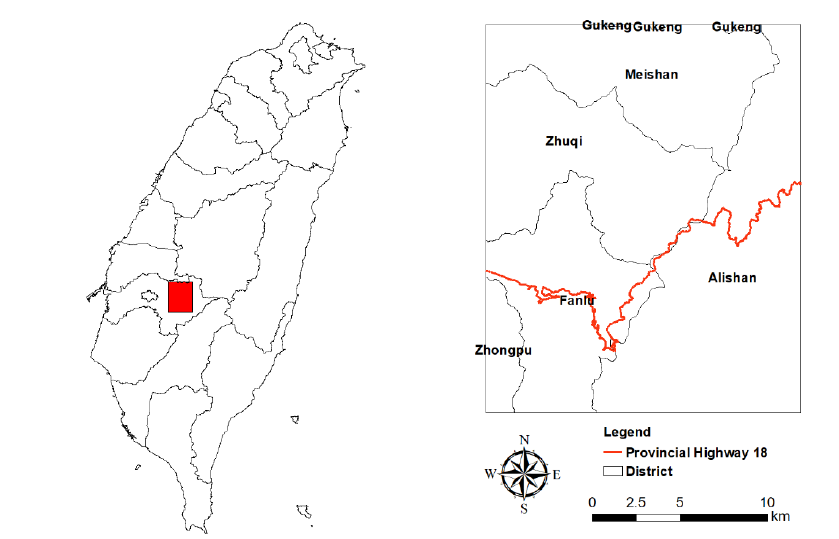
Figure 1. The study area is the area along Provincial Highway 18 and located in Fanlu Township and Alishan Township, Chiayi County.